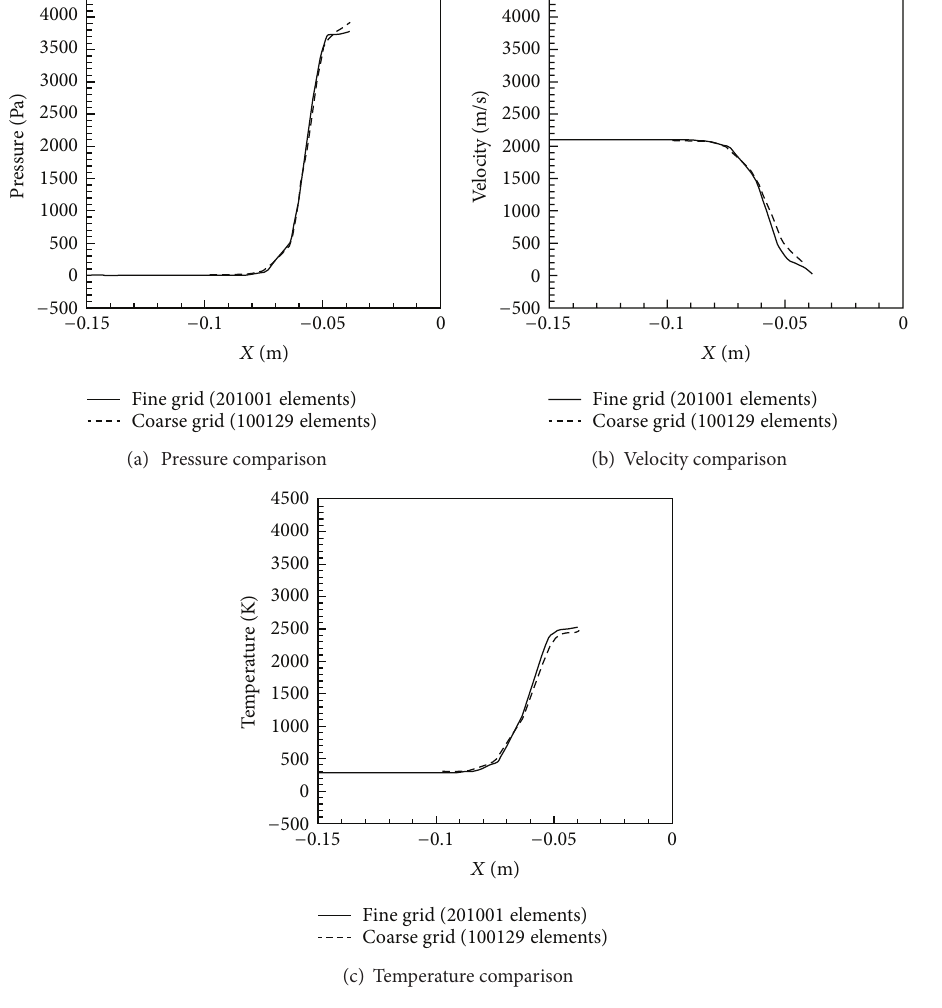
Figure 2: Grid independence comparison.